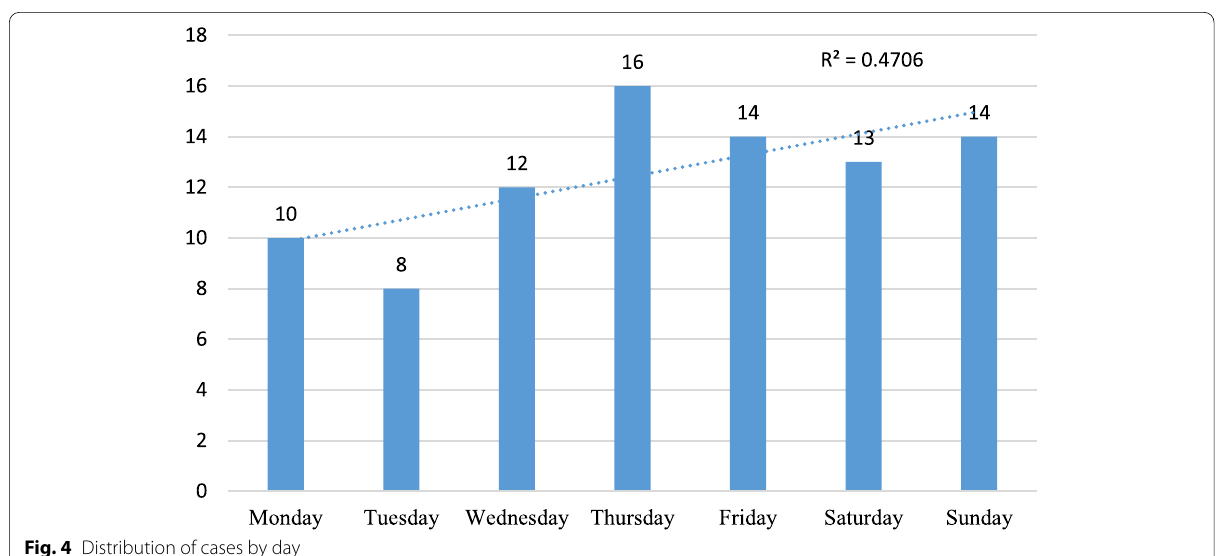
homicide in killing a boy aged 11 years (sharp force, relation between the method of homicide and sex ( p 0.084). Among the 15–18 age group, sharp force = only accounted for 52% of the deaths. In other two cases of this age group, sharp force was combined